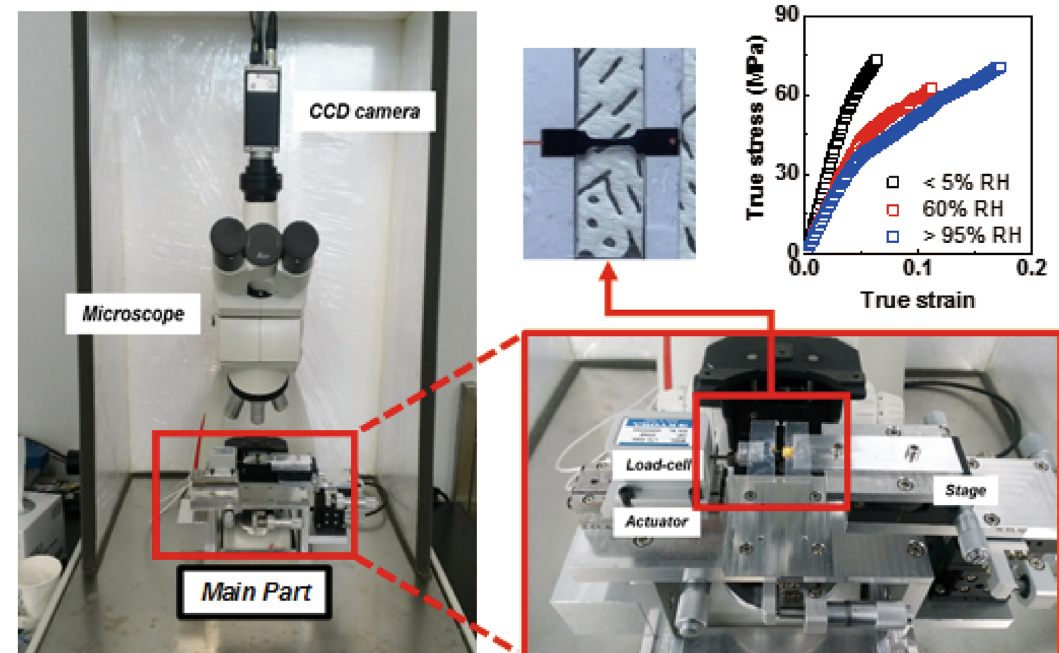
Fig. 13 Images of nano-UTM and PEDOT:PSS tensile samples, and typical stress – strain curves of PEDOT:PSS fi lms depending on